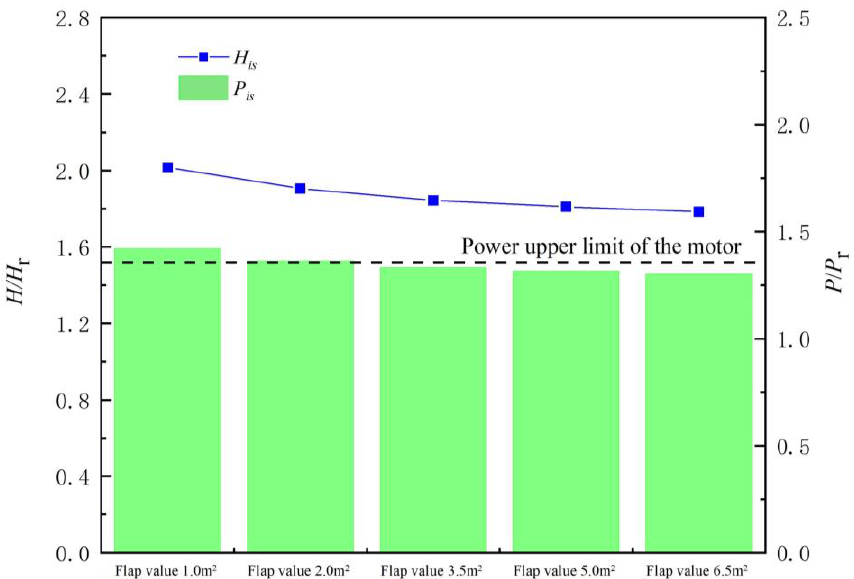
Figure 21. H is and P is of LAPS with FLVA and restricted OVHO under gate refusal working condi- tions.